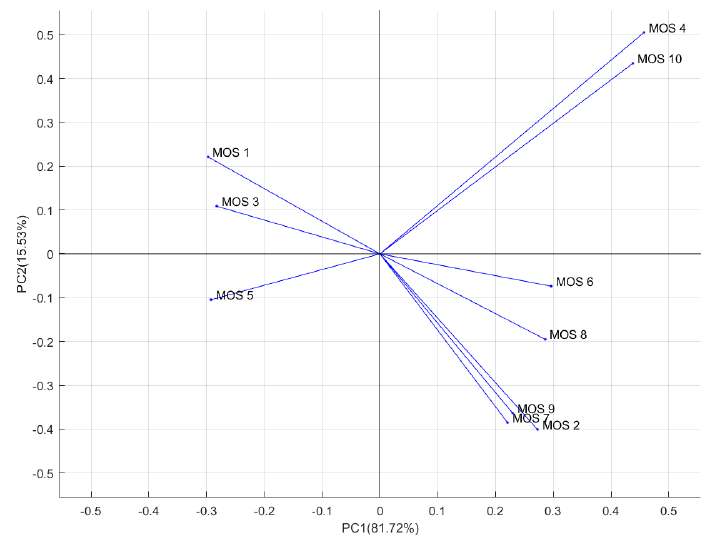
Figure 6. PCA loading plot of measurements about different levels of pears browning.